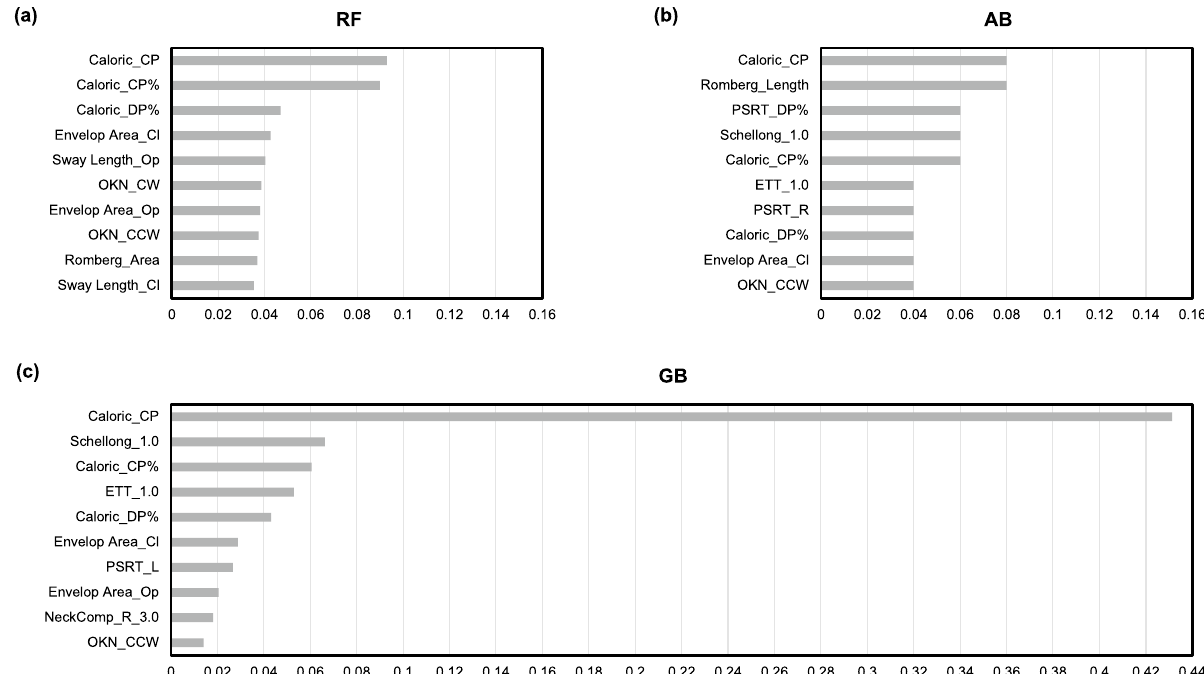
Figure 3. Top 10 most important features, ranked from high to low by classifier models. ( a ) Random forest. ( b ) Adaboost. ( c ) Gradient boosting. RF Random Forest, AB AdaBoost, GB Gradient Boosting, CP canal paresis in caloric test, DP directional preponderance in caloric test, PSRT pendular sinusoidal rotation test, R right, L left, Op open, Cl close, OKN optokinetic, CW clockwise, CCW counterclockwise, FFS failure of fixation suppression test, ETT eye tracking